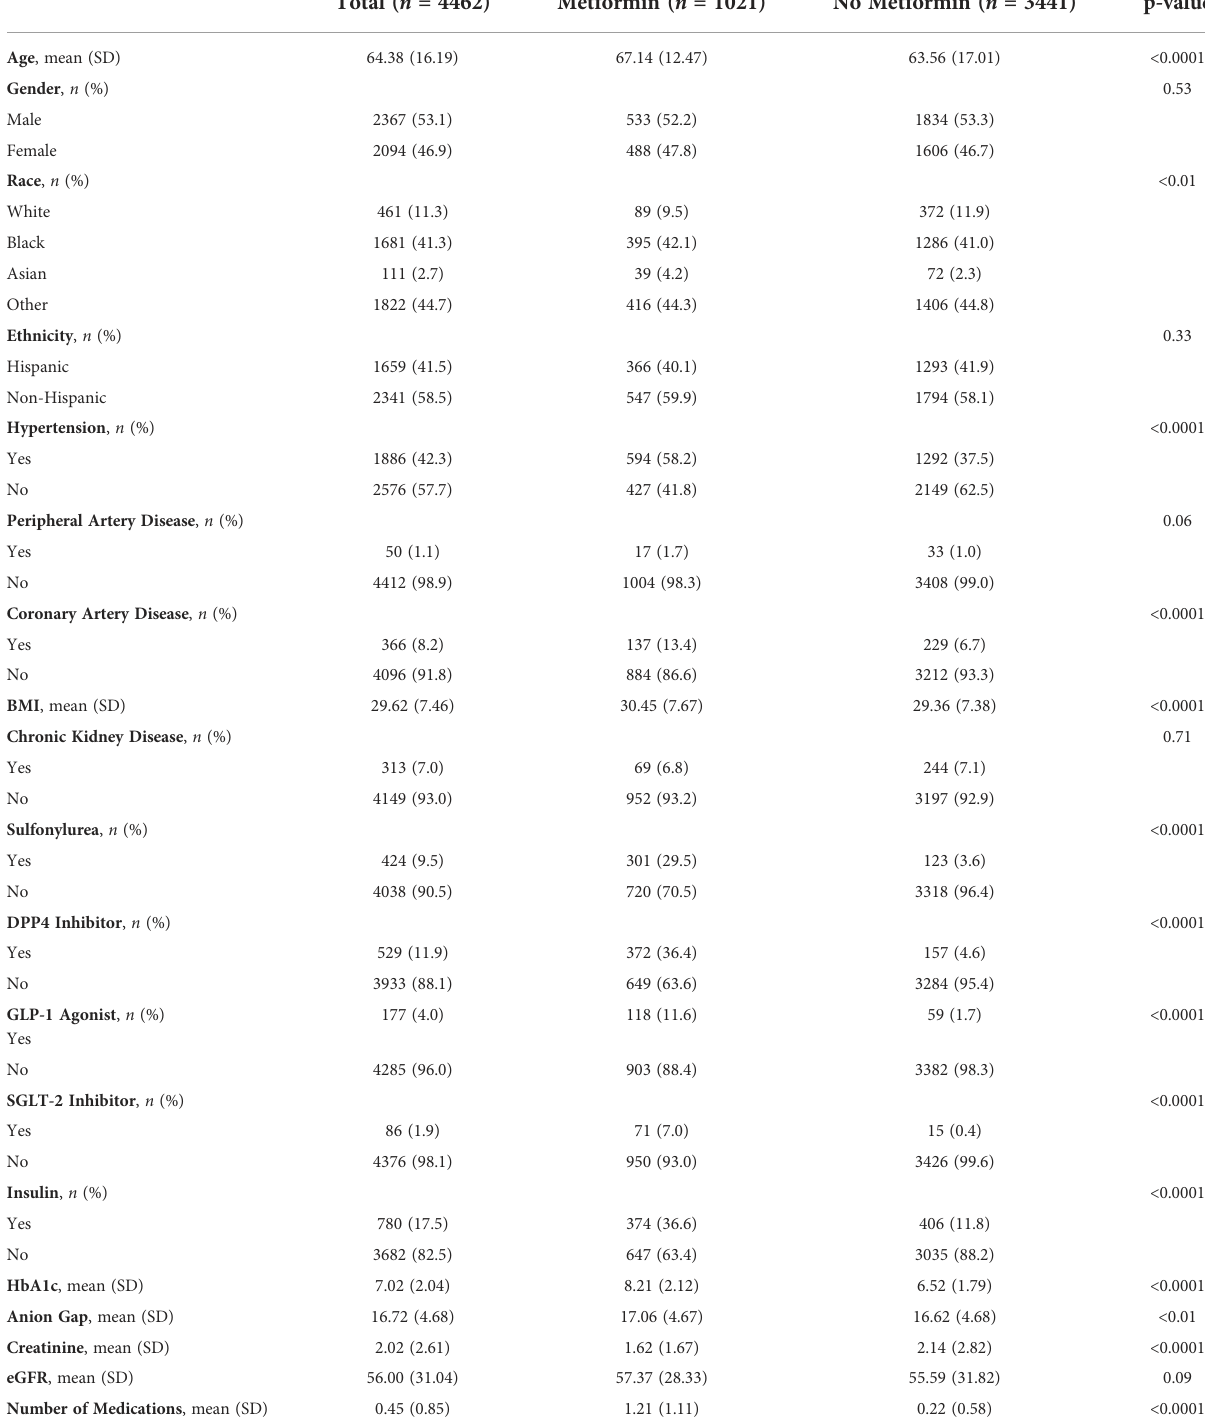
TABLE 1 Patient